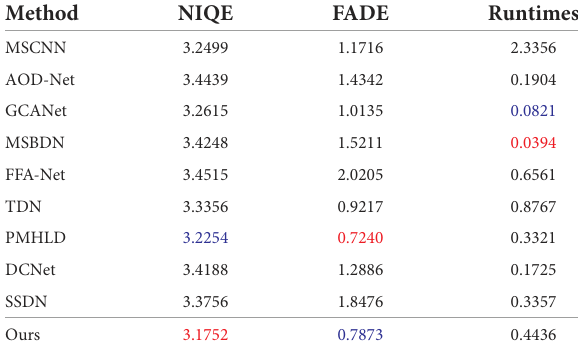
TABLE 1 Quantitatively compare the dehazing results with SOTA methods on the RESIDE and O-HAZE datasets.